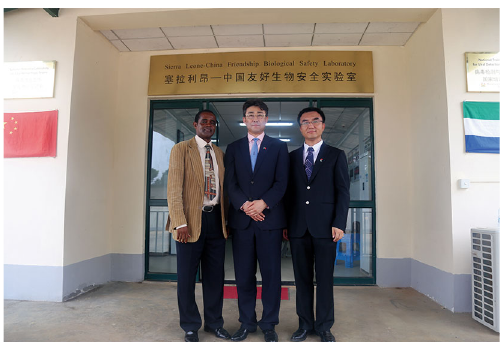
Figure 1. Training of the local health workers in Guinea to use the freely offered sanitary and biological protection supplies from China.